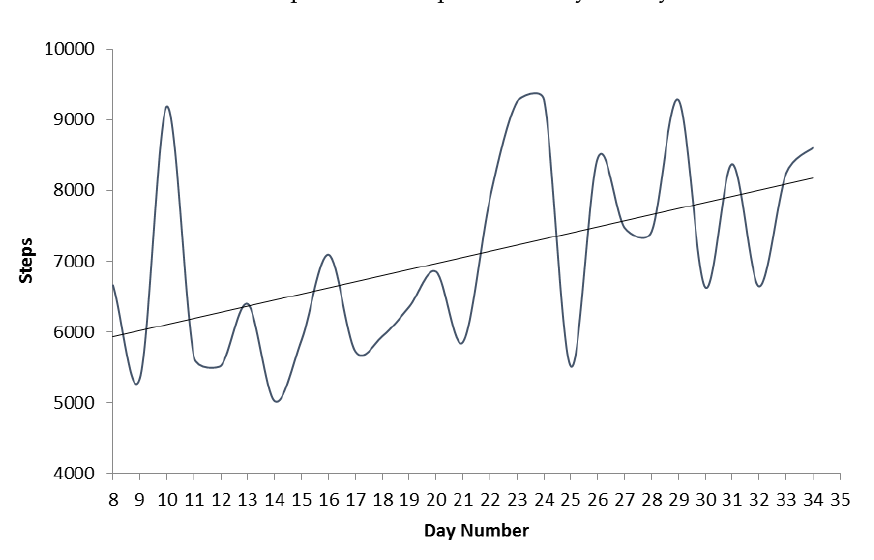
Figure 2. Daily mean step count of the group.